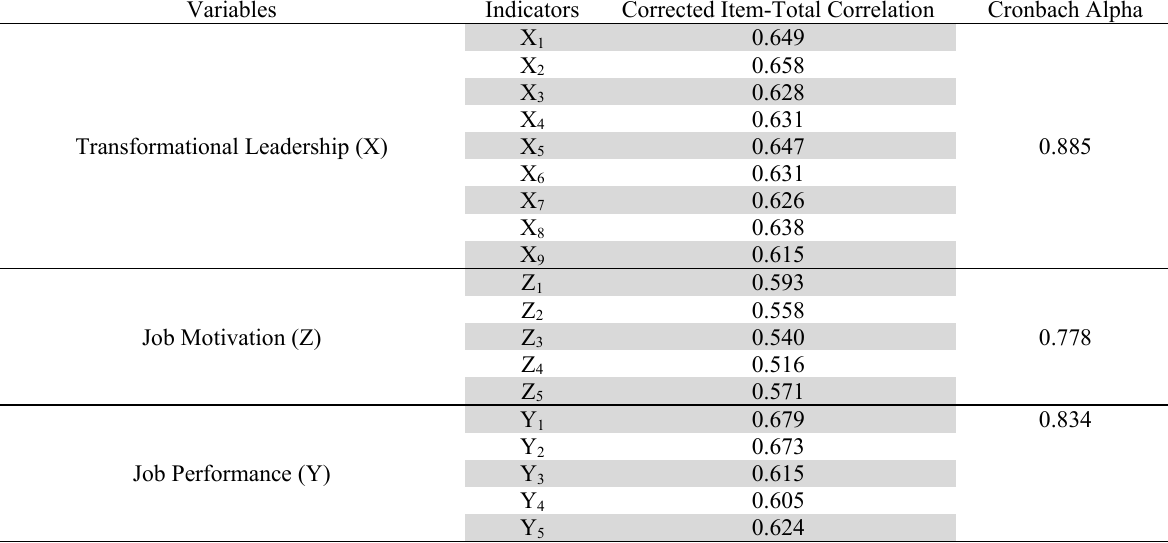
Results of Validity and Reliability Tests